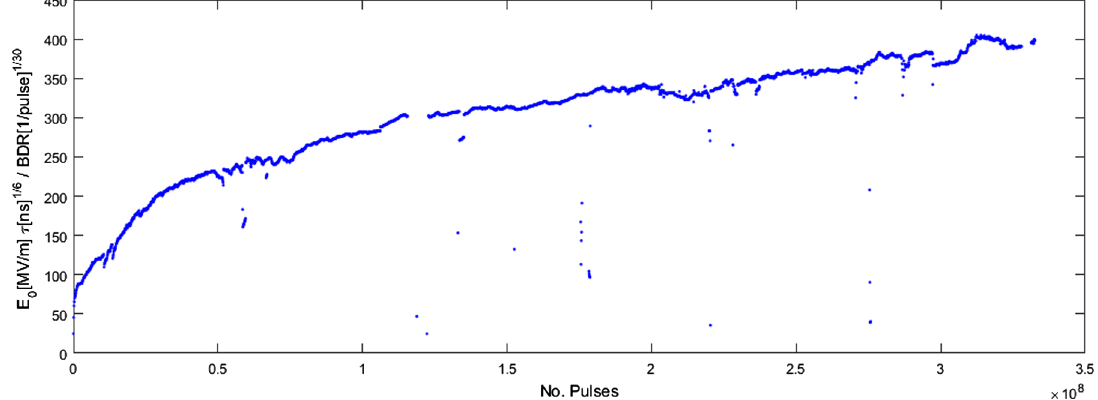
FIG. 2. Scaled gradient vs number of accumulated pulses for the structure TD26CC tested at CERN. The rescaling has been done applying the definition in Eq. (2).